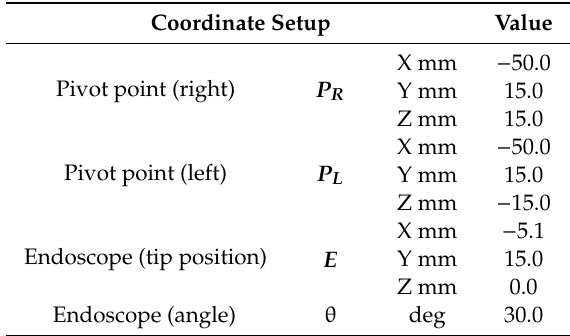
Figure 3. Robot coordinate system in the virtual environment. Table 1. Initial setup of pivot and endoscope.